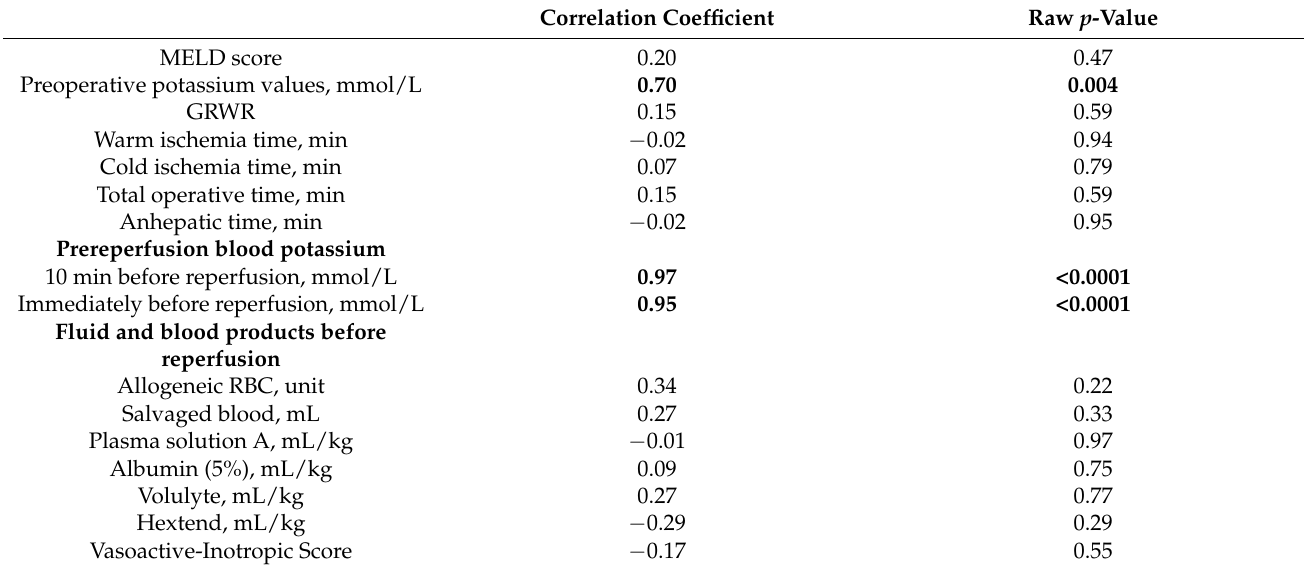
Table 3. Correlation analysis of perioperative factors associated with peak blood potassium after reperfusion. Correlation Coefficient Raw p -Value 0.20